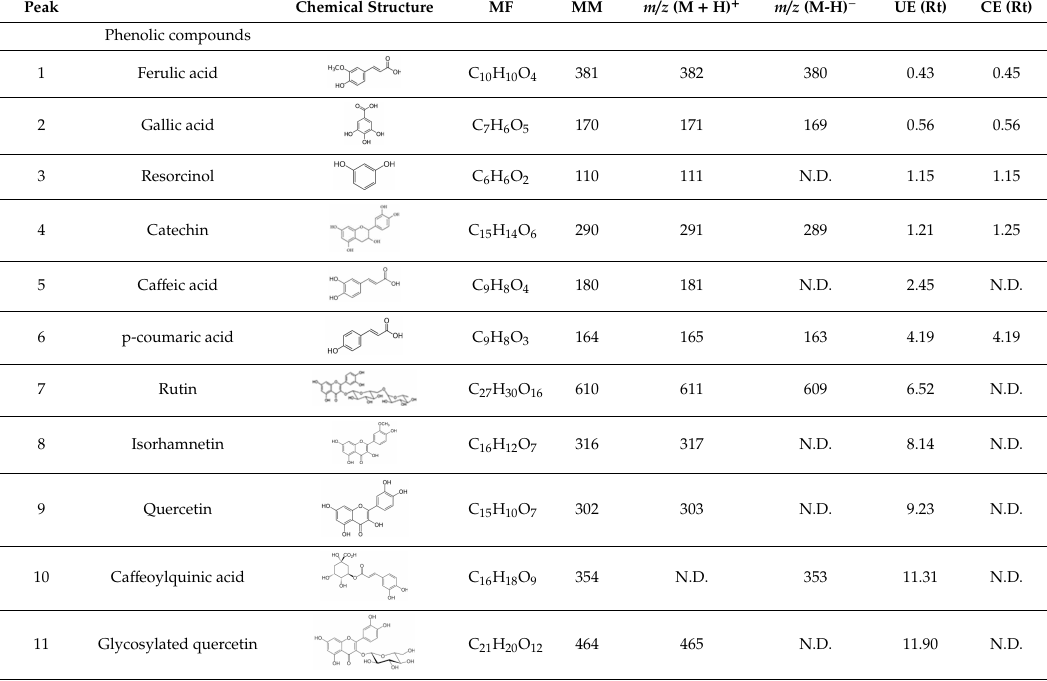
Table 3. Identification of possible phytochemicals present in the pitaya pulp ( Stenocereus thurberi ) of the UE and